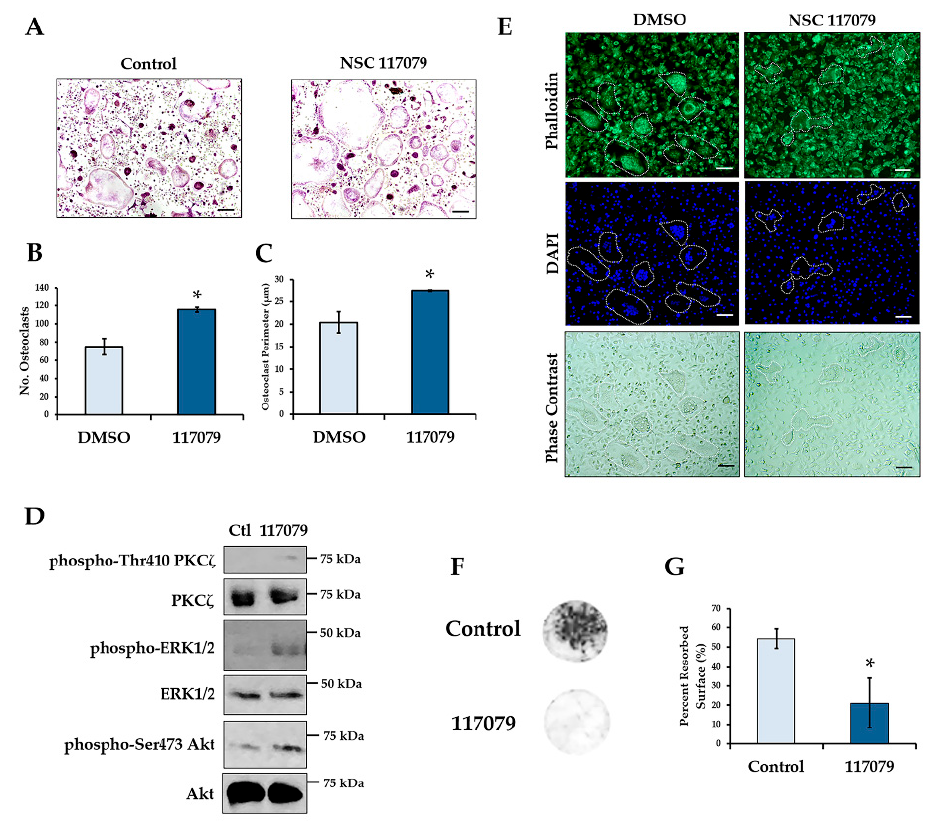
Figure 6. Phlpp inhibition reduces bone resorption ex vivo. Osteoclast progenitors were collected from 6–8-week-old C57Bl/6 females and cultured in the presence of the Phlpp inhibitor NSC 117079 in osteoclastogenic conditions. ( A ) TRAP staining was performed and the ( B ) number of osteoclasts and ( C ) average osteoclast area per field was determined, * p < 0.05. ( D ) Day 4 osteoclasts were stained with phalloidin and DAPI and bright field images were collected. ( E ) Western blotting was performed. ( F , G ) Osteoclasts were cultured on bovine bone disks in the presence of the Phlpp inhibitor NSC 117079 or control for 10 days. ( F ) Toluidine blue staining of the bone disks was performed, and ( G ) the average percent resorbed surface was determined. Scale bars are 100 microns.